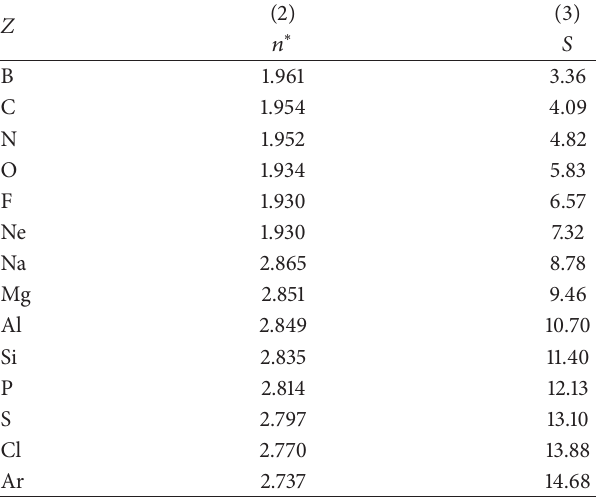
Table 9: Coefficients/constants proposed by Agmon to calculate ionization energies of isoelectronic